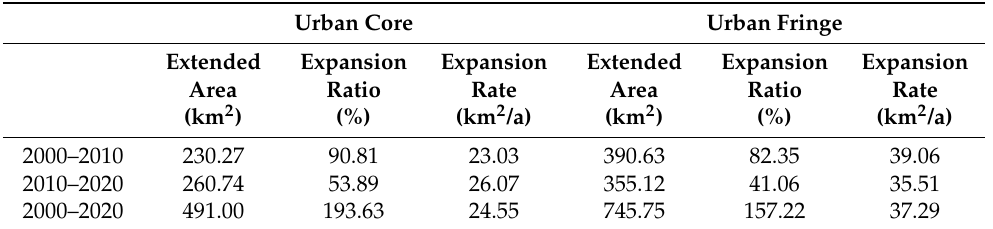
Table 4. Number of urban fringe expansions in Wuhan, 2000–2020.